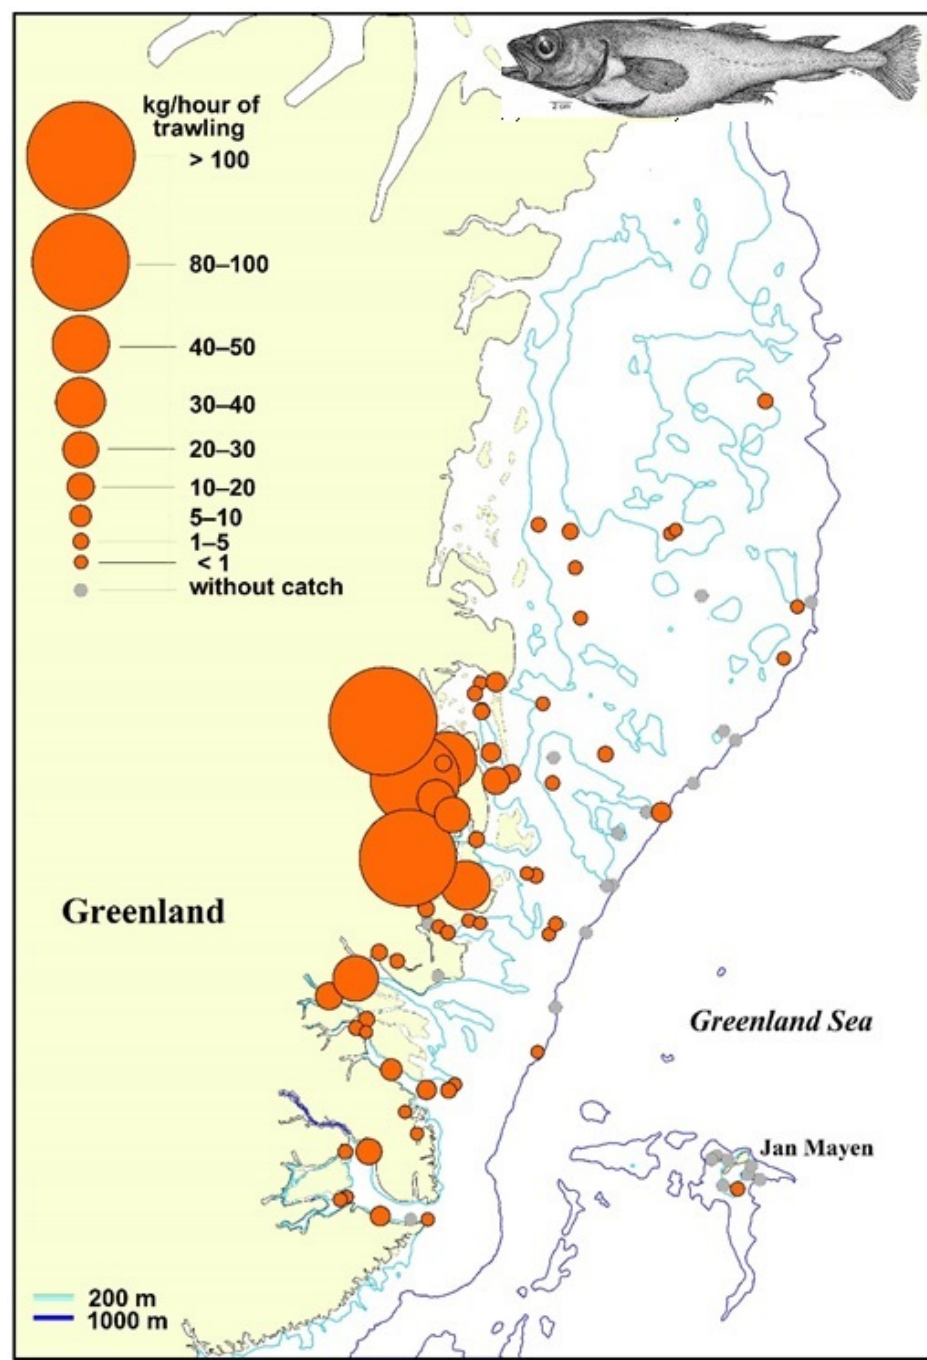
Figure 3. Geographic occurrence and abundance of ice cod Arctogadus glacialis across fjords and shelf stations (N = 53) in Northeast Greenland, cf. Table 1. Filled symbols show catches of ice cod in kg/h. Inserted illustration of ice cod, courtesy of Birgitte Rubæk (https://www.birgitterubaek.work/, accessed on.1 November 2022).